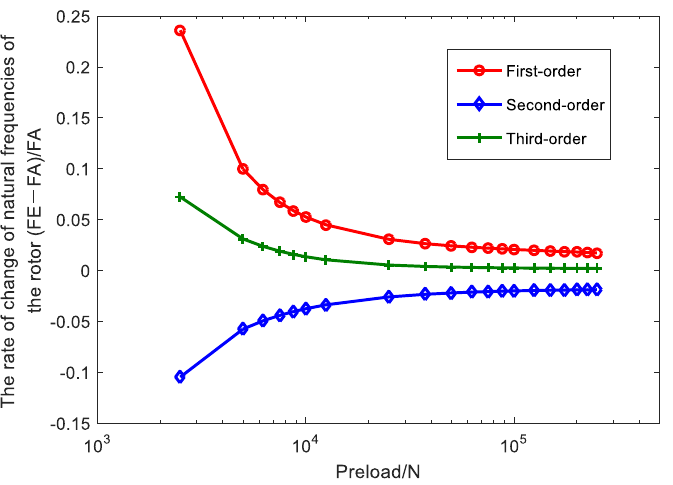
Figure 16. The rate of change of natural frequencies of the RFR considering all factors caused by tie rods.